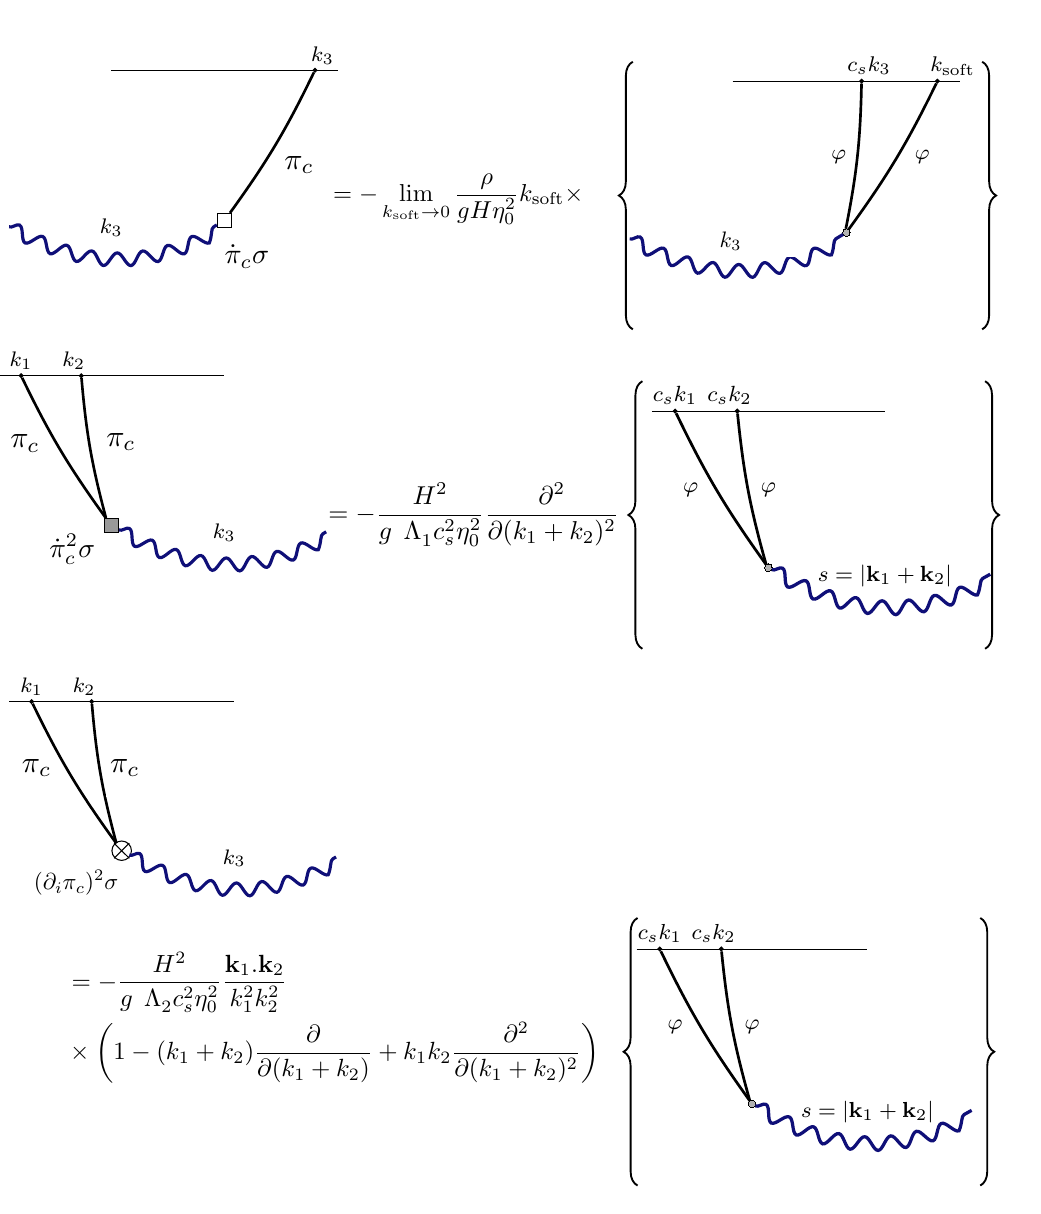
Figure 6 . In this table we have collected the relationships between the building blocks of the correlators of π and those of the four-point function of ϕ . By multiplying the operators that act on c each vertex in Diagrams A, B1 and B2 and for the trispectra, one can deduce the weight shifting operators that relate the full diagrams to ˆ F , as presented by equations (3.31), (3.34) and (3.37).